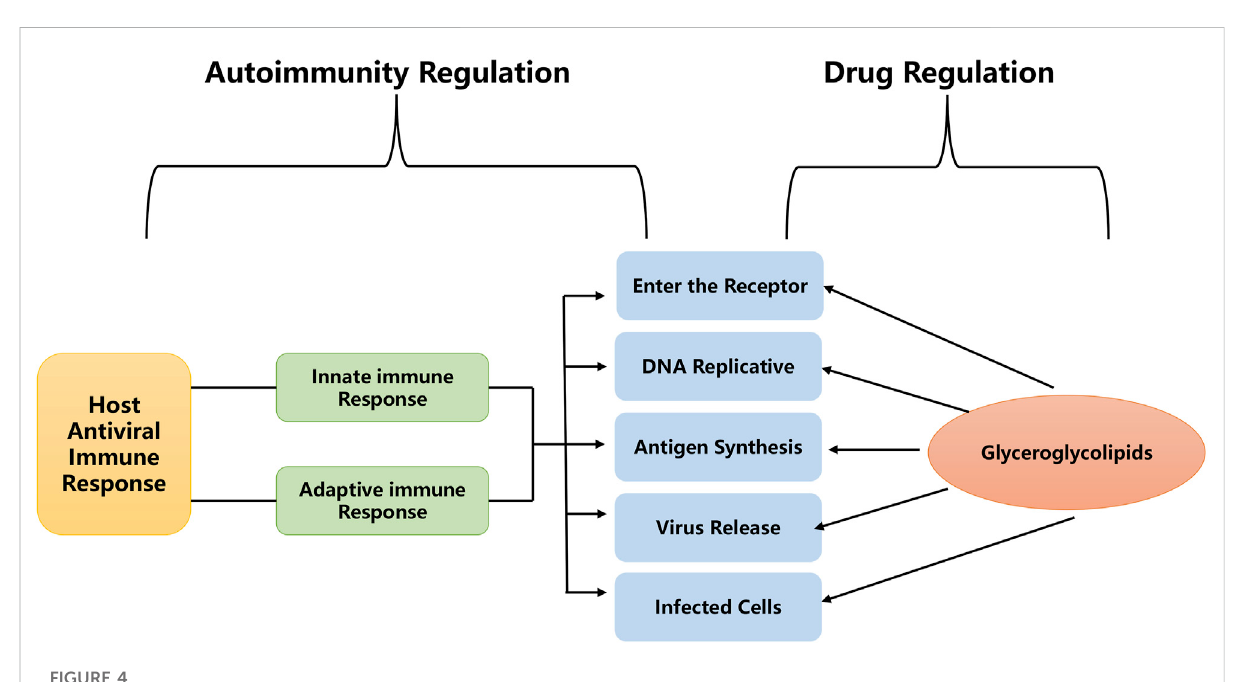
FIGURE 4 Potential anti-viral mechanism of